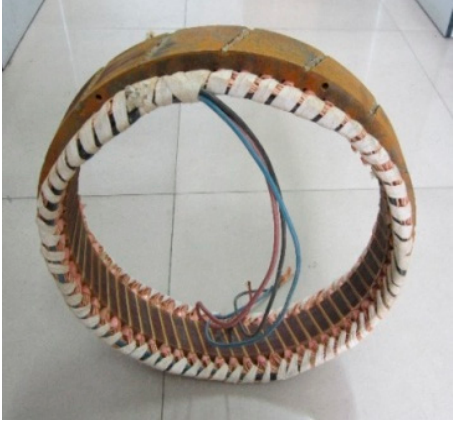
Figure 2. Traditional RDT ( a ) Prototype of RDT and ( b ) Overall efficiency of RDT at different .